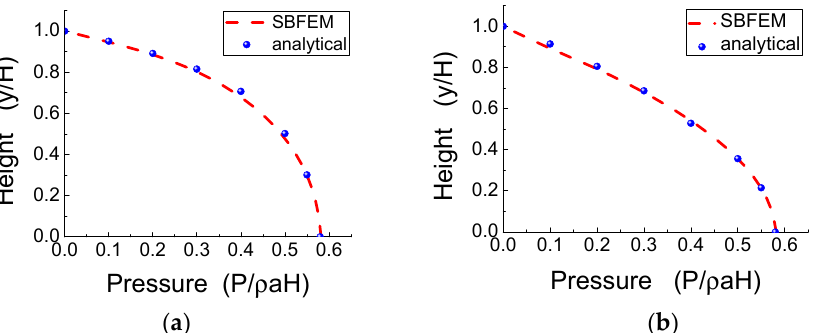
Figure 13. Triangular valley with upstream–downstream excitation: ( a ) along line AB and ( b ) along line AC.